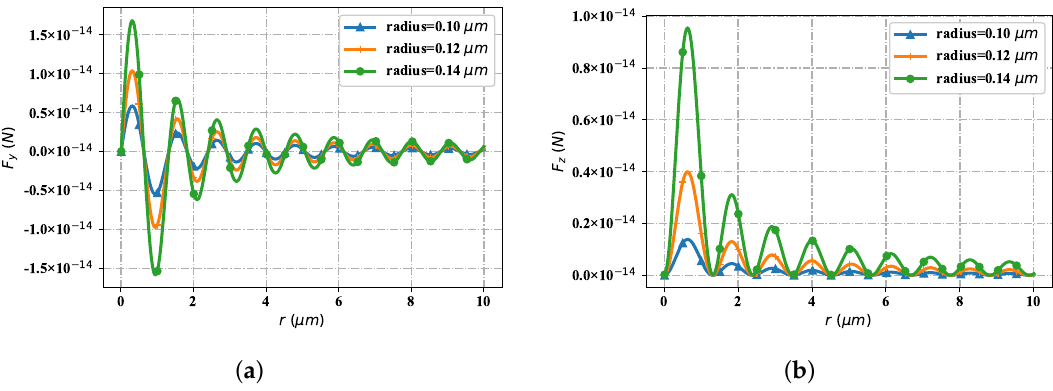
Figure 12. The implication of spherical radius for the changing of F y and F z . ( a ) F y with radius; ( b ) F z with